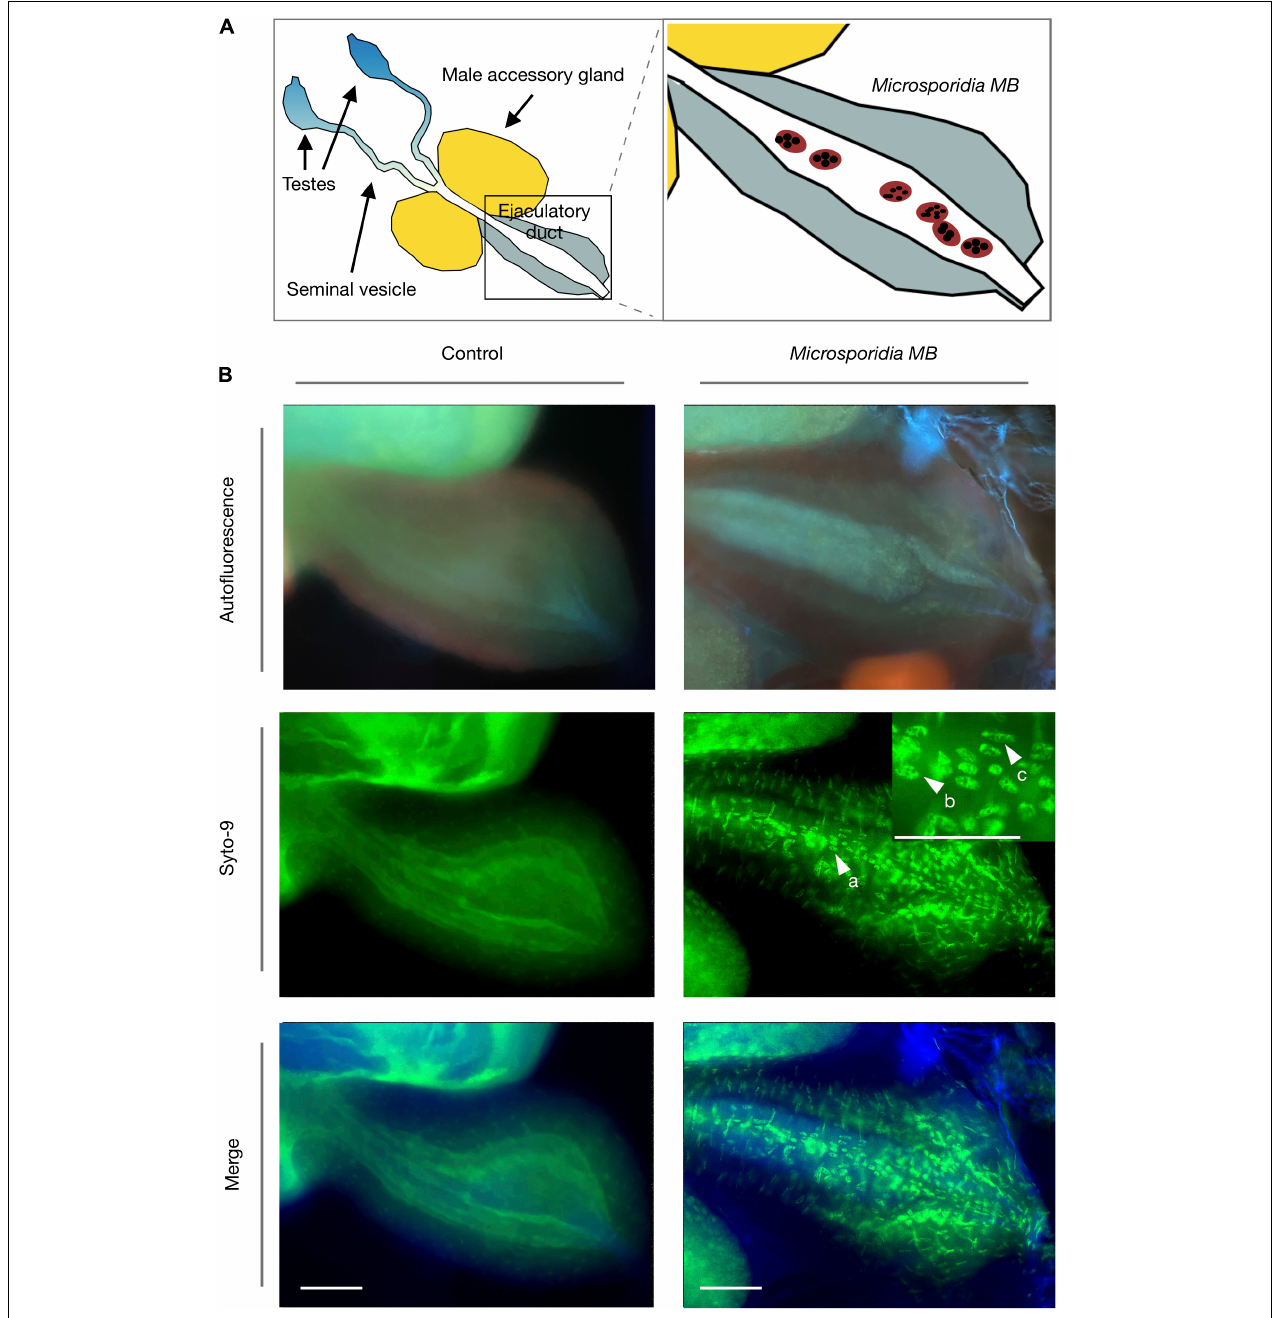
FIGURE 3 | Fluorescence microscopy of Microsporidia MB in An. arabiensis male ejaculatory ducts. (A) Schematic diagram of the male Anopheles gonad shows the position of the ejaculatory duct in relation to seminal vesicle, male accessory gland and testes. (B) Fluorescence microscopy images indicate that Microsporidia MB meronts (a) are found in the male An. arabiensis ejaculatory duct. Multinucleate Microsporidia MB cells can be observed containing 4 and 8 distinct nuclei (b,c), which likely corresponds to the progression on of 4-nuclei sporogonial plasmodia into the 8-nuclei sporogonial plasmodia and ultimately into sporophorous vesicles. Scale bar = 50 µ